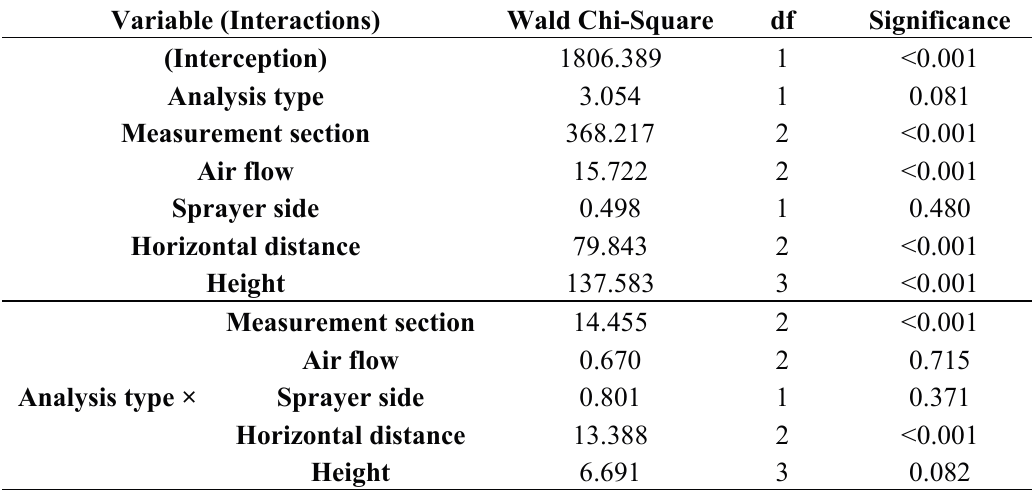
Table 4. Effect of variables on air velocity when using generalized linear model with sum of squares Type III, results contrast Omnibus: Chi square likelihood ratio = 440.292; p < 0.001. Deviation obtained with this model in relation to a gamma distribution with a logarithmic link function was